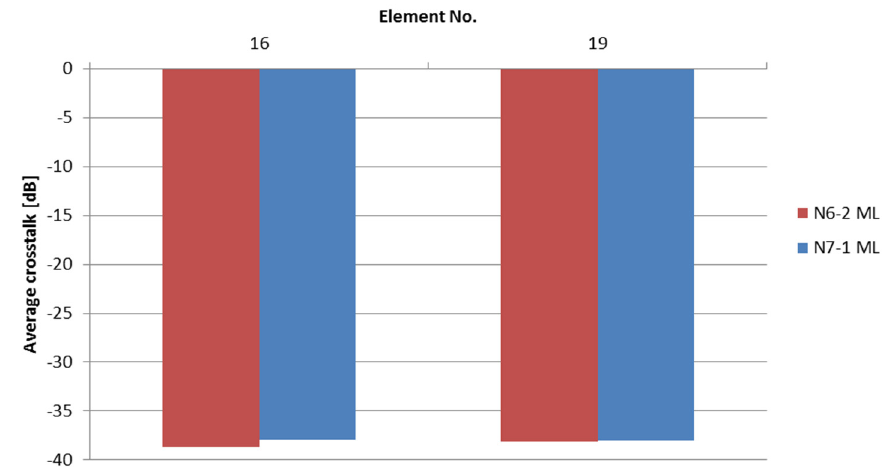
Figure 5. Cross-talk measured at time zero for two typical elements (No. 16 and 19) of two linear arrays. The average crosstalk is found to be approximately − 38 dB.